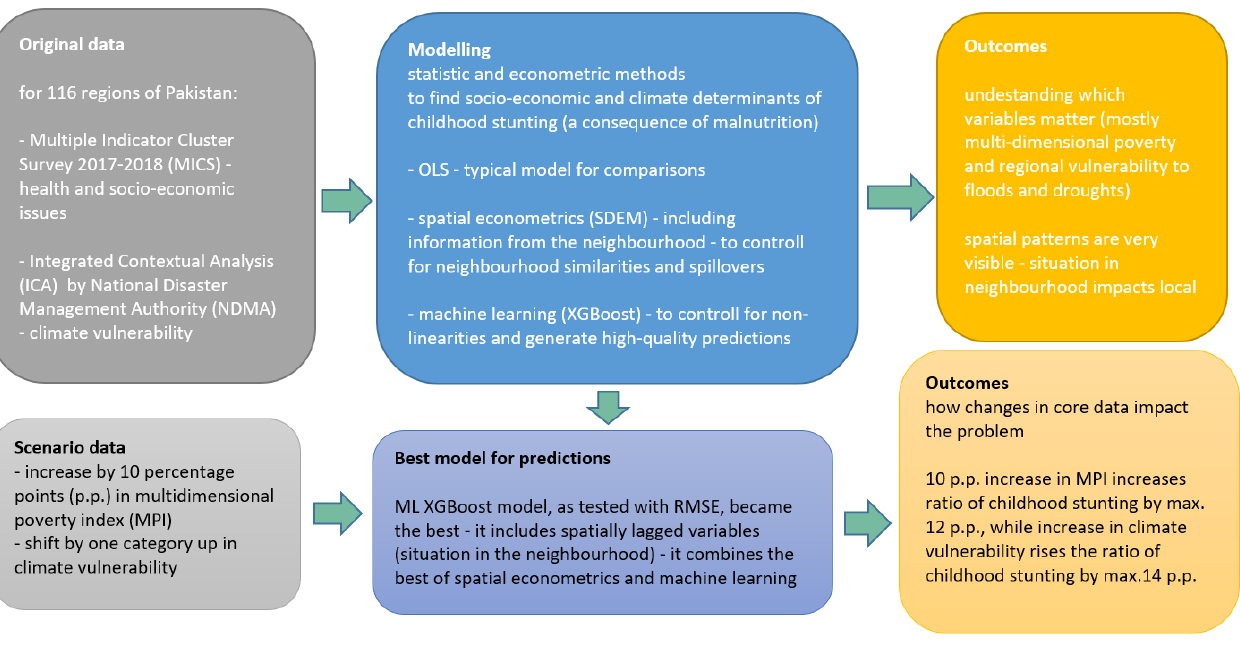
Figure 3. Flowchart of the study.